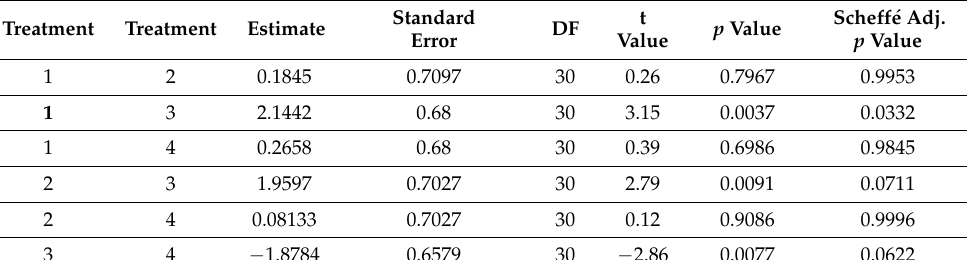
Table 4. Differences of least squares means for PC7 scores. The Scheff é adjusted p values show that TR3 scores are significantly different from TR1 scores (bolded). DF = degrees of freedom. Treatment high positive loadings for spectral features that can be assigned to fatty acids, BHB, ace- tone and citrate. It also showed negative loadings for spectral features that can be assigned to lactose. This observation suggests that lactose had an inversed relationship with fatty acids, BHB, acetone and citrate in milk samples collected during the last three weeks of the trial (i.e., long-term effect of the tie-rail configuration treatment application). In addi- tion, treatment TR3 tended to differ from treatment TR2 ( p = 0.0711, less restricted than TR3 in its height from the stall base) and treatment TR4 ( p = 0.0622, less restricted than TR3 in its forward position from the manger wall).